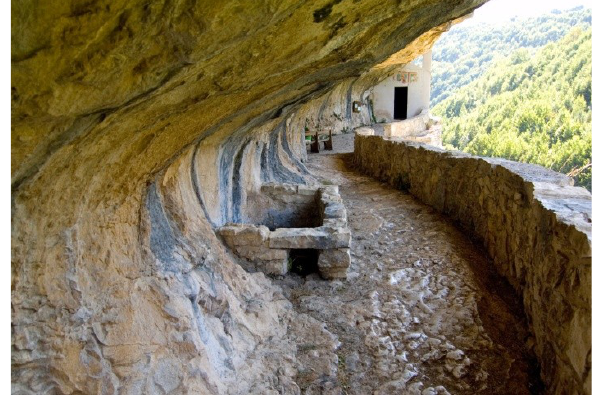
Figure 3. Hermitage entrance from the upper walkway shot by frontal flight, perpendicular to the facade, not being visible with zenithal views. A comparison was then carried out between a previous survey with 3D laser scanner, Faro LS1105, and the described acquisitions, obtained from ground and from drone with Agisoft Photoscan, in order to compare the two plots and the measurement differences obtained with the